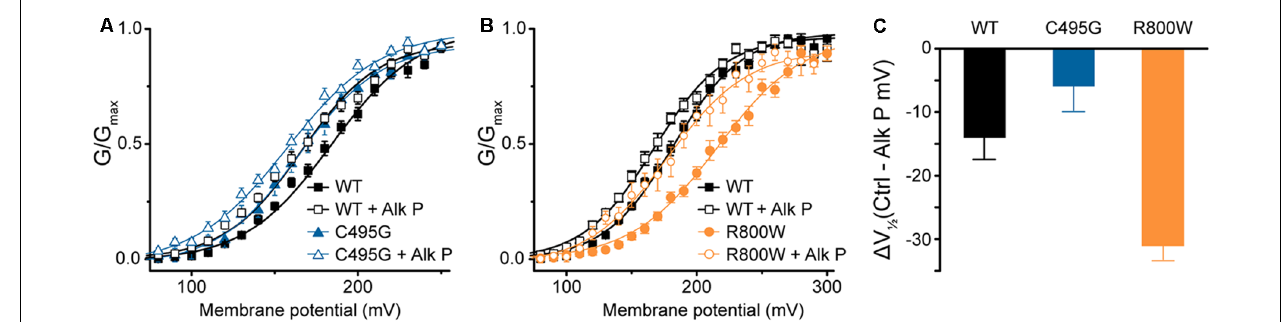
FIGURE 5 | Effects of dephosphorylation on C495G and R800W hBK VYR currents. (A,B) G–V relationships from BK currents recorded in symmetrical K + at 1- µ M Ca 2 + for control hBK VYR (WT) and C495G (A) or R800W (B) channels in control conditions or in the presence of dephosphorylating agent alkaline phosphatase (Alk P) in the intracellular solution. Voltage protocols were identical to those used in Figure 2 . Alk P treatment was associated with a significant leftward G–V shift for each construct (WT, P = 0.03; C495G, P < 0.0001; R800W, P < 0.0001). C495G + Alk P was significantly different compared with WT + Alk P ( P < 0.0001). R800W + Alk P was significantly different compared to WT + Alk P ( P = 0.02). Significance ( P < 0.05) was tested using one-way ANOVA with Bonferroni post hoc test comparing V 1 / 2 values for each construct between control and Alk P conditions and between WT and SNPs constructs within each treatment condition. (C) ∆ V 1 / 2 plot summarizing the magnitude of the V 1 / 2 shift due to Alk P for each construct (Average V 1 / 2 control − Average V 1 / 2 + Alk P). N = 9–20 recordings per construct for each treatment